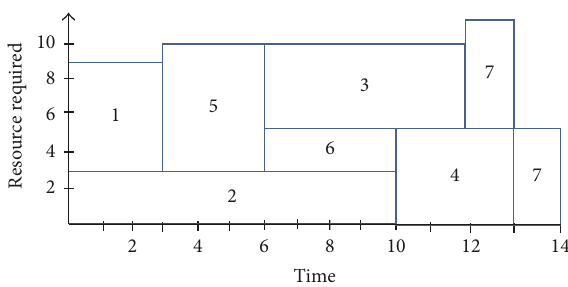
Figure 2: The optimal schedule of the sample